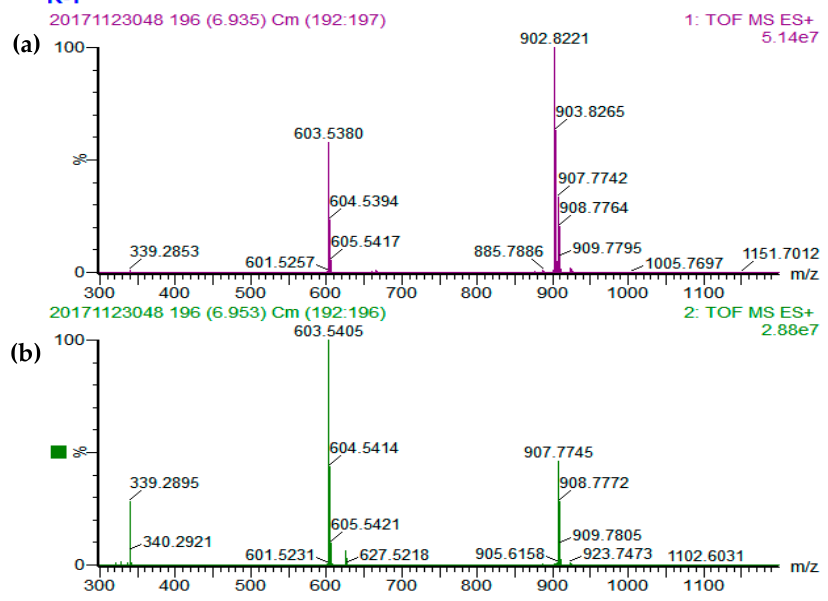
Figure 2. MS spectra of O-O-O. ( a ) MS 1 spectrum and ( b ) MS 2 spectrum.